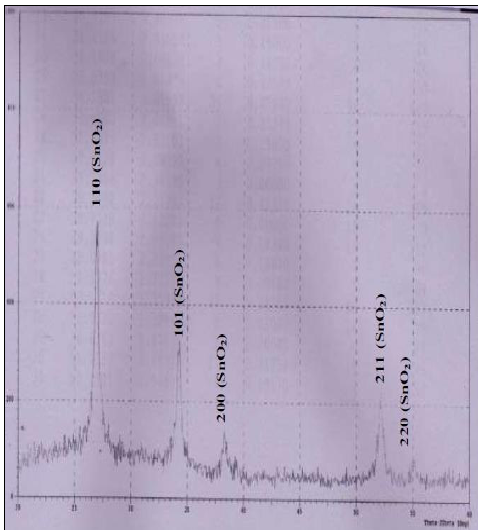
Fig.6 XRD Spectra of Z